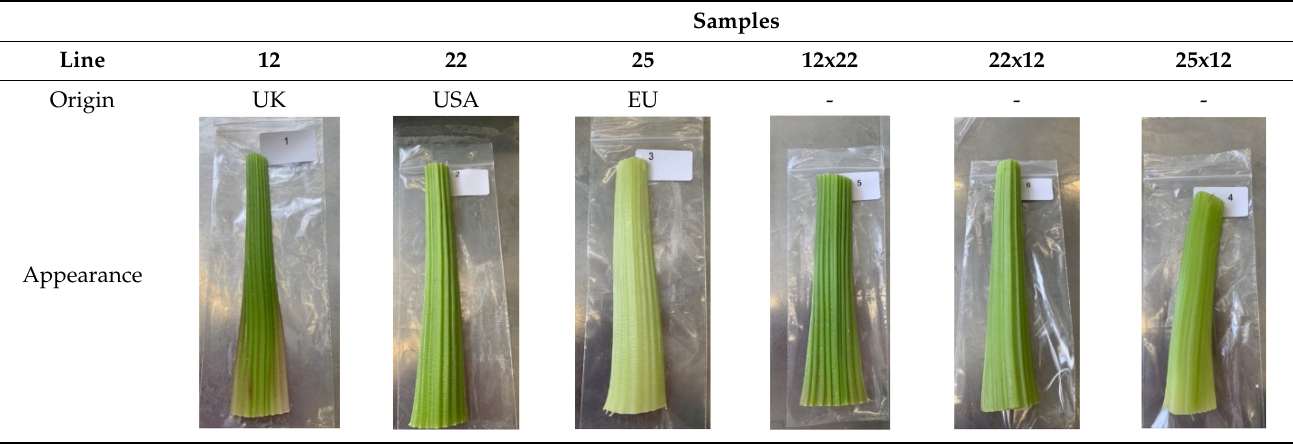
Table 9. Images of the petioles of the six celery samples used in this